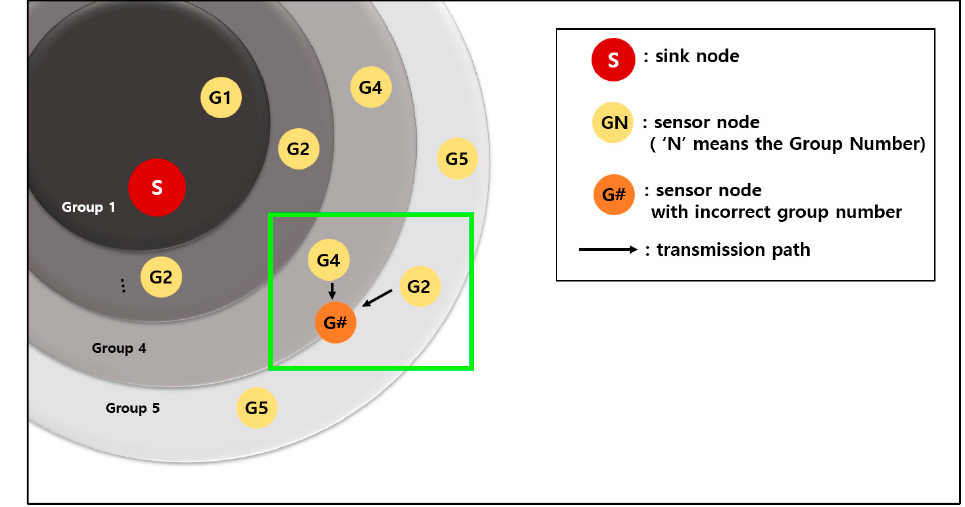
Figure 17. Group number resetting scenario.